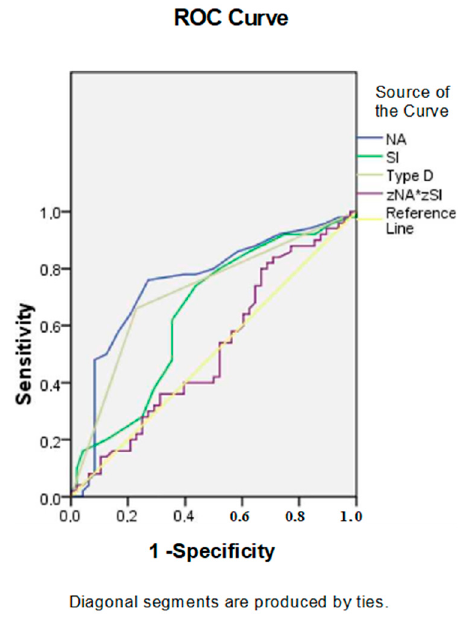
Figure 1. Receiver operating characteristic curve analysis. Performance efficacy of the personality. Type D parameters in the escape–avoidance strategy detecting. Notes: NA, negative affectivity; SI, social inhibition; zNA × zSI, effect of subscales interaction.